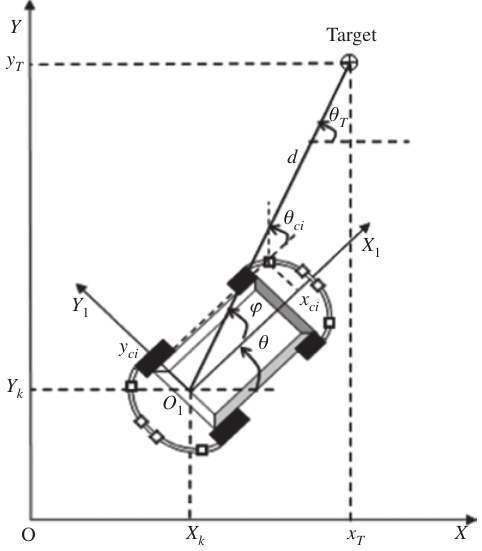
Figure 3: Wheelchair and Sensor Position in the